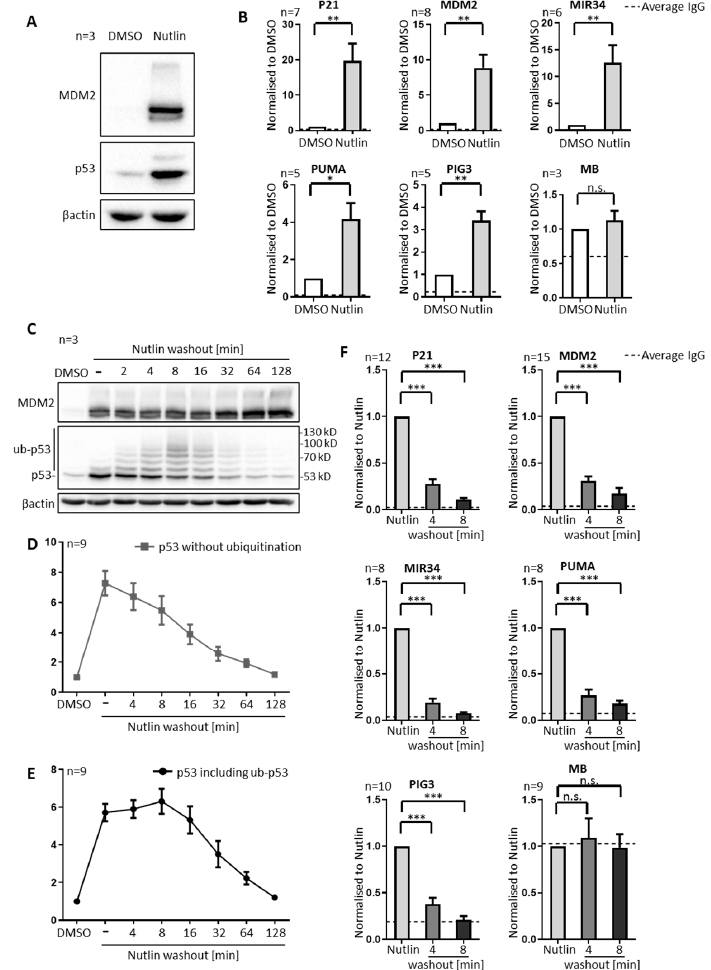
Figure 1. Immediate elimination of p53 from promoter DNA upon Nutlin washout. Experiments were performed in SJSA cells treated with 20 μ M of Nutlin, or the amount of the DMSO solvent alone, for 4 h. ( A ) A representative immunoblot (out of three) showing the induction of p53 and MDM2 in SJSA cells upon Nutlin treatment. ( B ) Chromatin immunoprecipitation (ChIP) analyses followed by quantitative real-time PCR (qPCR) were performed to determine the degree that p53 was occupying the promoters of its target genes P21 (CDKN1A), MDM2, MIR34 (MIR34AHG), PUMA (BBC3), PIG3 (TP53I3) and myoglobin (MB, negative control). The analysis revealed a significant increase in chromatin-bound p53 upon Nutlin treatment at target genes but not at the negative control site. Enrichment of chromatin-bound p53 was normalized to the amount of chromatin input and to the DMSO-treated sample and displayed as mean + SEM from the indicated number (n) of biological replicates. The dotted line shows the background signal, i.e., the average enrichment upon chromatin immunoprecipitation with unspecific immunoglobulin G (IgG). ( C ) P53 is progressively ubiquitinated and degraded upon Nutlin treatment and subsequent washout, while MDM2 remains stable throughout the observation period of 128 min (immunoblot analysis). ( D ) Quantification of the signal corresponding to non-modified p53, from immunoblot analyses of nine biological replicates, including the ones that are shown in ( C ) and in Figure 3 through 8. Results are displayed as mean + SEM. ( E ) Analysis equivalent to ( D ) but now comprising both non-modified p53 and ubiquitinated p53 with higher apparent molecular weight, reflecting early ubiquitination but slower degradation. ( F ) ChIP analysis performed as described in ( B ) but comparing the association of p53 with promoters before and shortly after Nutlin washout. Of note, p53 was found removed from its target gene promoters within four and eight minutes of Nutlin washout. *** p < 0.001; ** p < 0.01; * p < 0.05; n.s.,